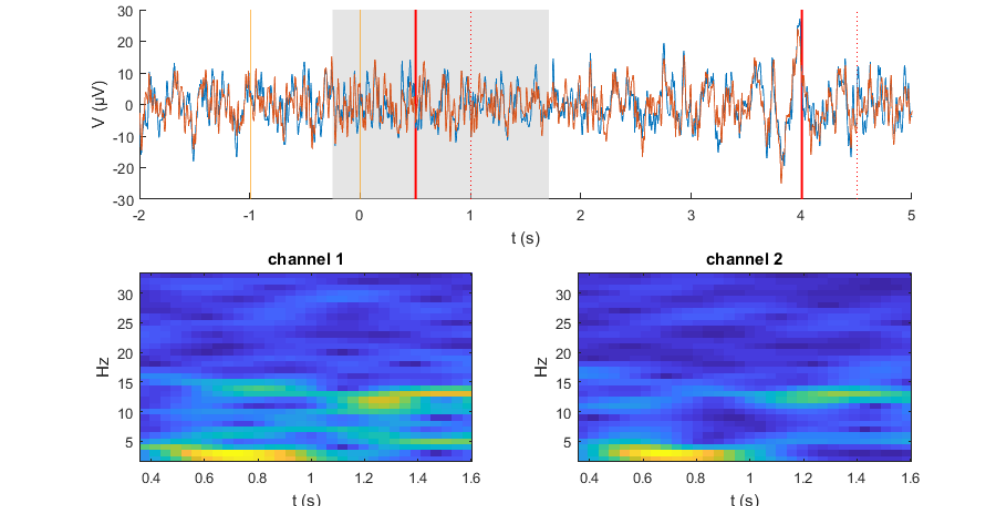
Figure 7. A frame of a live stream. Top : Filtered signal during a trial. Blue and red traces illustrate channel 1 and channel 2, respectively. Vertical lines indicate visual (orange) and acoustic cues (red). Bottom : Generated spectrograms from data within the grey rectangle shown above.